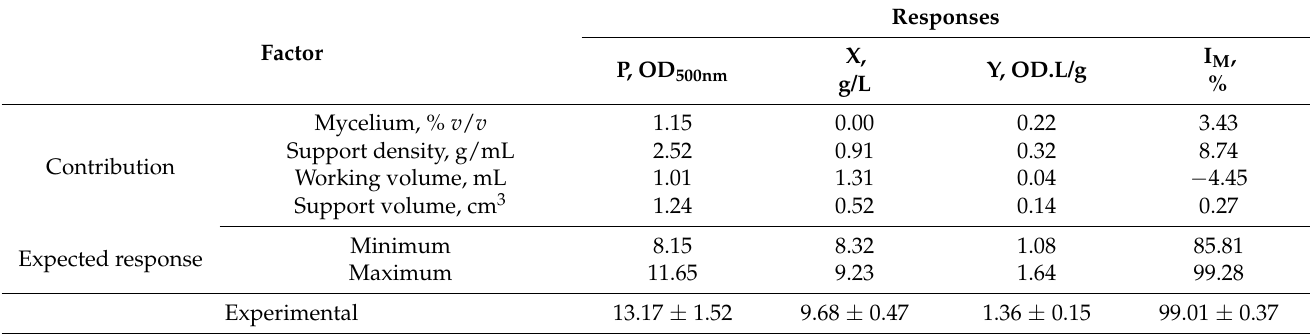
Table 3. Contribution of improved settings to each evaluated target, expected response within a confidence level and experimental result at improved